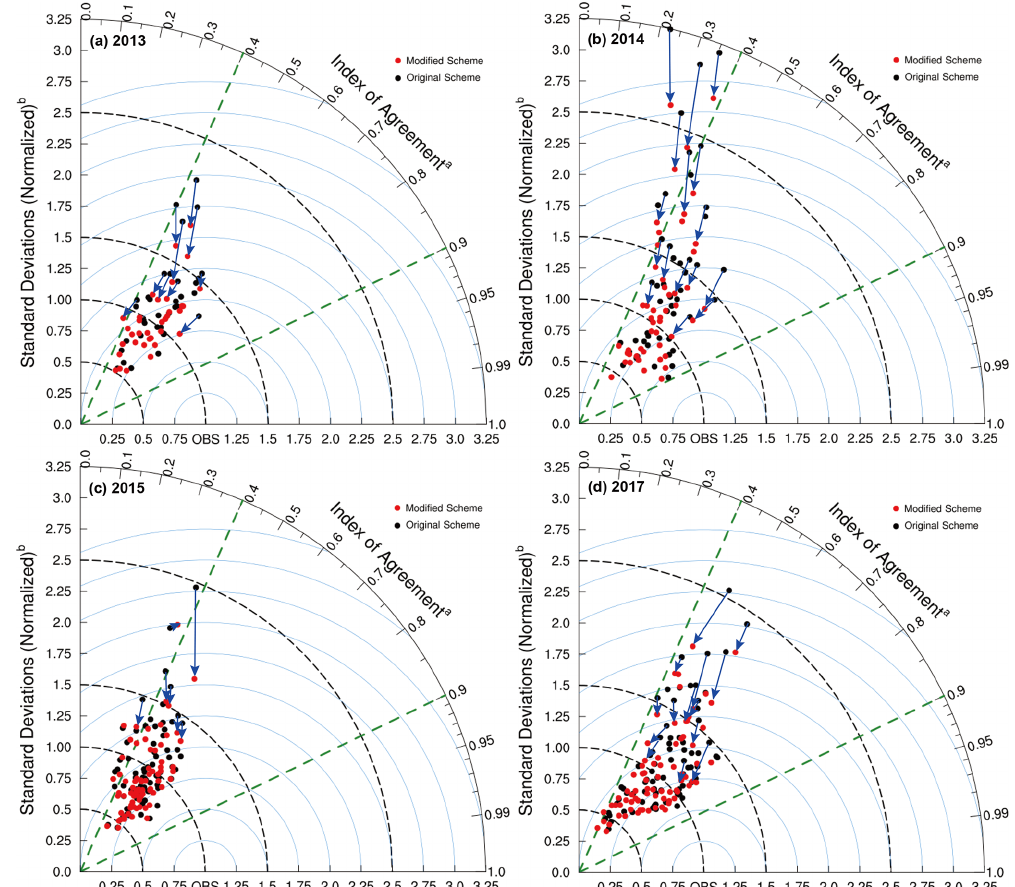
Figure 5. Taylor diagram of simulation by original scheme and modified scheme. XY axes and arcs represent the normalized standard devia- tions (NSDs; NSD =